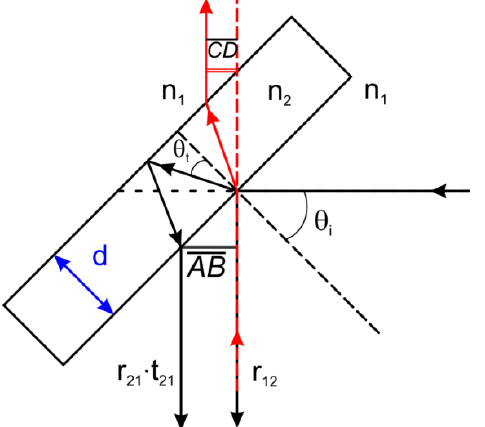
Figure 2. Optical paths of the reflected and the refracted rays on the first beam